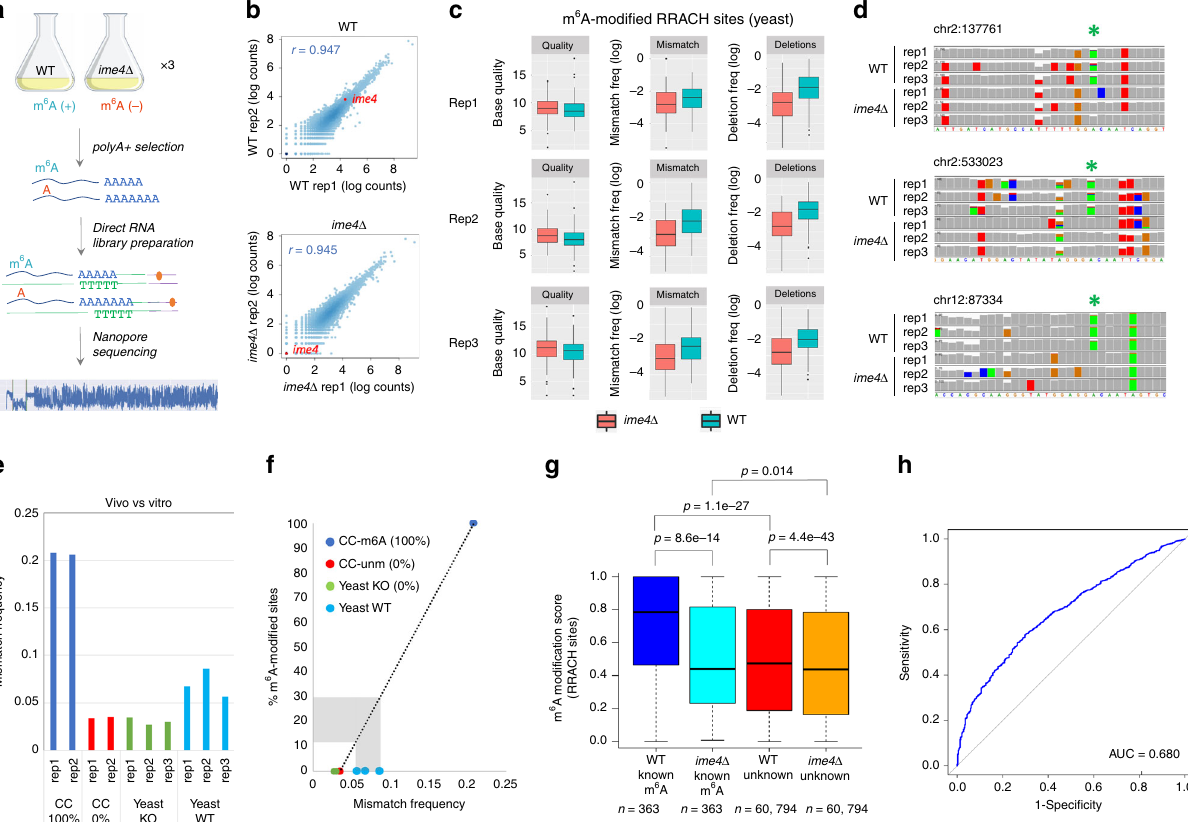
Fig. 3 Yeast wild-type and ime4 Δ strains show distinct base-called features at known m 6 A-modi fi ed RRACH sites. a Overview of the direct RNA sequencing library preparation using in vivo polyA( + ) RNA from S. cerevisiae cultures. b Replicability of per-gene counts using direct RNA sequencing across wild-type yeast strains (top) and ime4 Δ strains (middle). The correlation between wild-type and ime4 Δ strains is also shown (bottom). c Comparison of the observed mismatch frequencies in the 100%-modi fi ed in vitro transcribed sequences (blue), unmodi fi ed sequences (red), yeast ime4 Δ knockout (green), and yeast wild type (cyan). Values for each biological replicate are shown. d Base-called features (base quality, insertion frequency, and deletion frequency) of RRACH 5-mers known to contain m 6 A modi fi cations. Only features corresponding to the modi fi ed nucleotide (position 0) are shown. Features extracted from wild-type yeast reads (m 6 A-modi fi ed) are shown in blue, whereas those from ime4 Δ (unmodi fi ed) for the same set of k-mers are shown in red. f Genomic tracks of previously reported m 6 A-modi fi ed RRACH sites in yeast, identi fi ed using Illumina sequencing. The m 6 A-modi fi ed nucleotide is highlighted with a green asterisk. In these positions, wild-type yeast strains show increased mismatch frequencies, as well as decreased coverage — re fl ecting increased deletion frequency — in all three biological replicates, whereas these features are not observed in any of the three ime4 Δ replicates. g Predicted m 6 A modi fi cation scores predicted by the trained SVM at known m 6 A-modi fi ed ( n = 363) and unknown ( n = 60,794) RRACH sites, both for yeast wild-type and ime4 Δ data sets. P -values have been computed using Kruskal – Wallis test. A site was included in the analysis if there were mapped reads present in all six yeast samples. Sites with more than one “ A ” in the 5-mer were excluded from the analysis. h ROC curve depicting the performance of EpiNano in yeast data sets ( n = 61,363 sites). Error bars indicate s.d. Source data are provided in the Source Data fi